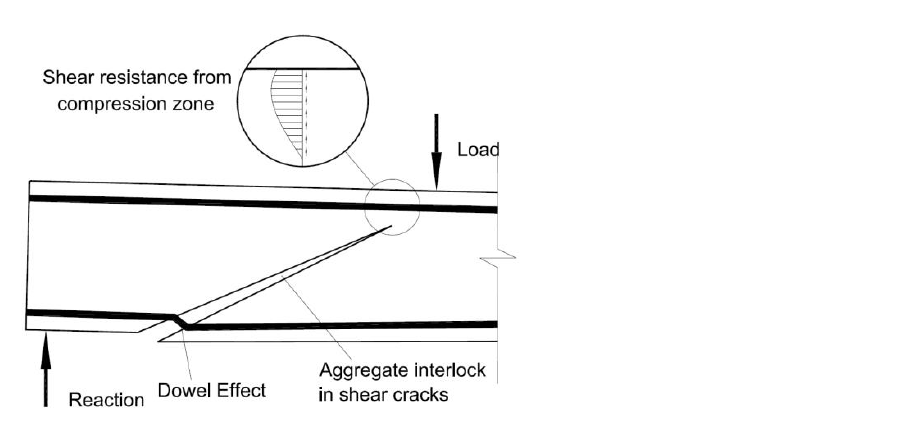
Figure 1. Shear-carrying mechanism of FRP-reinforced concrete beams without shear reinforce- ment.